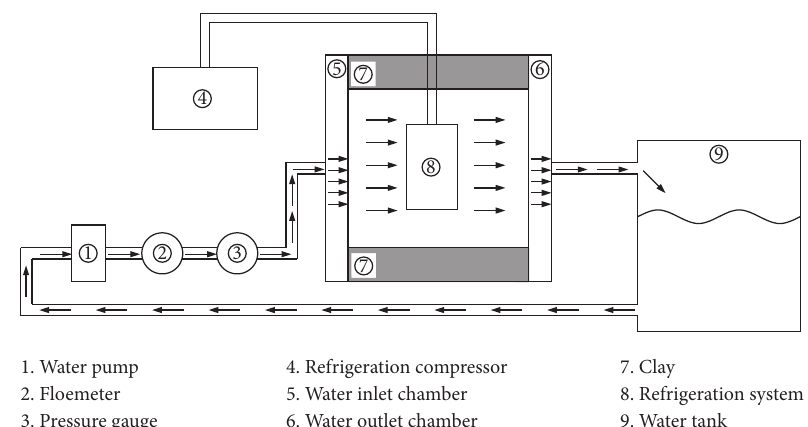
Figure 2: Schematic diagram of the freezing model test system.